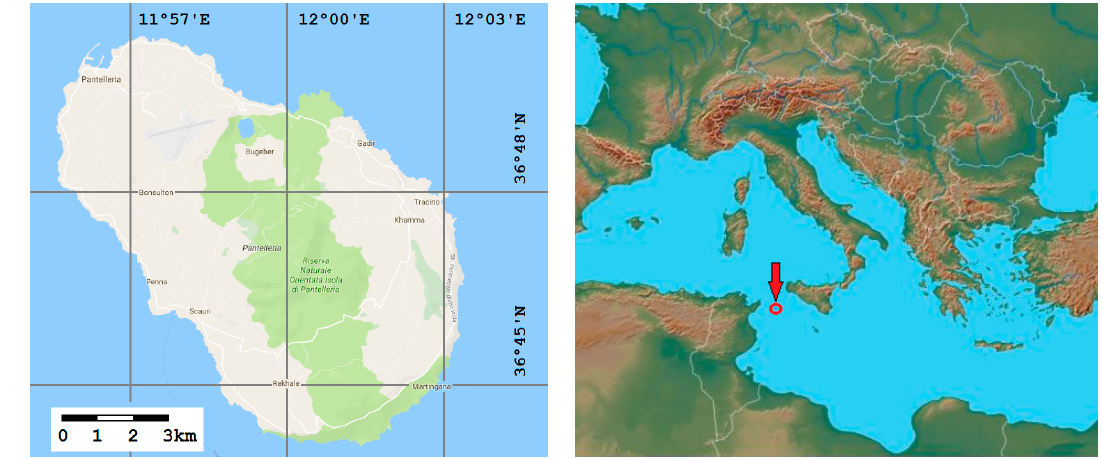
Figure 1. The island of Pantelleria with its location in the Mediterranean Sea.